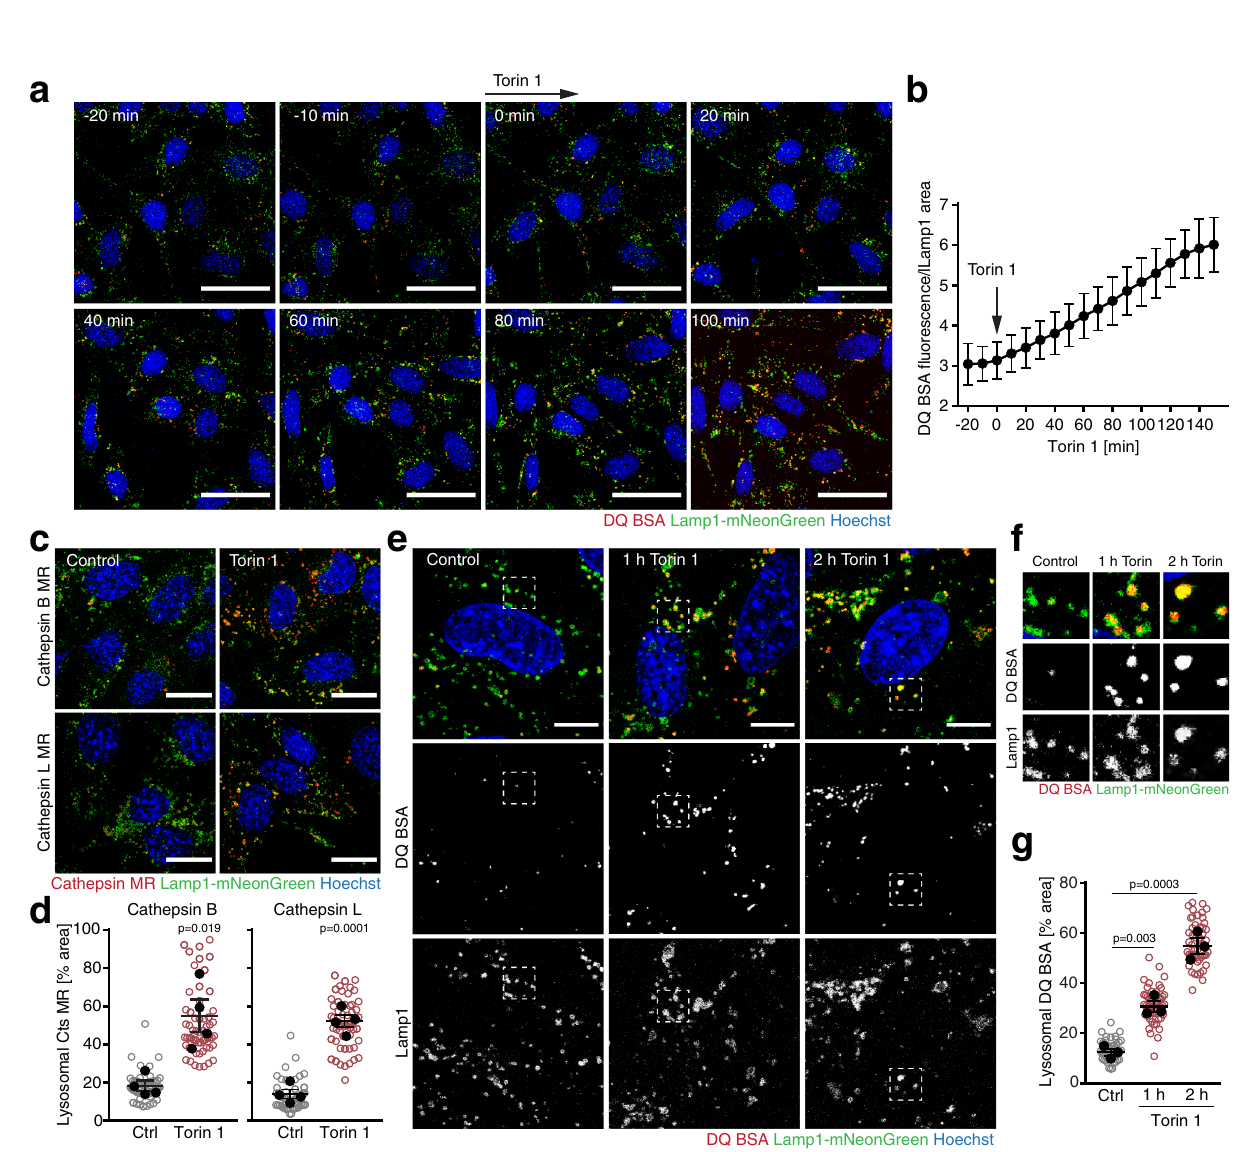
Fig. 5 | The V-ATPase V 1 domain reversibly associates with the cytosolic cha- peronin TRiC. a , b Cartoon summarizing SILAC quanti fi cation data of proteins in Co-IPs from MEFs with a Flag-Voa3, b HA-V1B2. c , d Changes in protein abundance in SILAC Co-IPs with c Flag-Voa3, d HA-V1B2 for 1h aa starvation ( − aa) versus full medium, or for 1h aa starvation+30min aa restimulation versus 1h aa starvation (+aa). e Changes in V-ATPase subunit abundance in Cct1 and Cct2-de fi cient MEFs, analysed by western blot. f Western blot quanti fi cation of V-ATPase subunit abundance changes in Cct1 and Cct2-de fi cient cells as in e . Data are normalized replicate mean±SEM. The dashed line indicates protein levels in control cells. g Fluorescence quenching of lysosomally loaded FITC-dextran in Cct2-de fi cient MEFs±1h torin 1 [400nM]. h Quanti fi cation of FITC fl uorescence quenching of Cct2-de fi cient cells±torin 1 as in g . Data are normalized replicate mean±SEM (closed circles) and fi elds of view (open circles; ≥ 10 per replicate). i Fluorescence